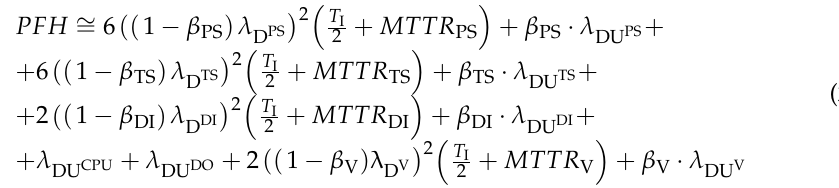
Table 11. Result for different E/E/PE architectures.